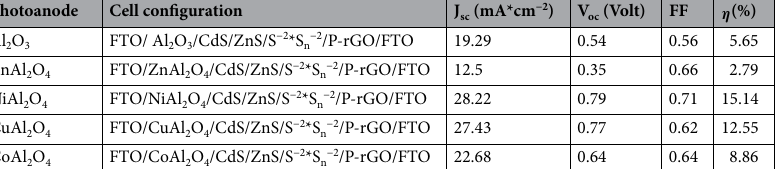
Table 4. Photovoltaic parameter of Al 2 O 3 NP s and MAl 2 O 4 with hybrid structure of (6 cycles CdS/6 cycles of ZnS QD s ) as a photosensitizer with P-rGO as a counter